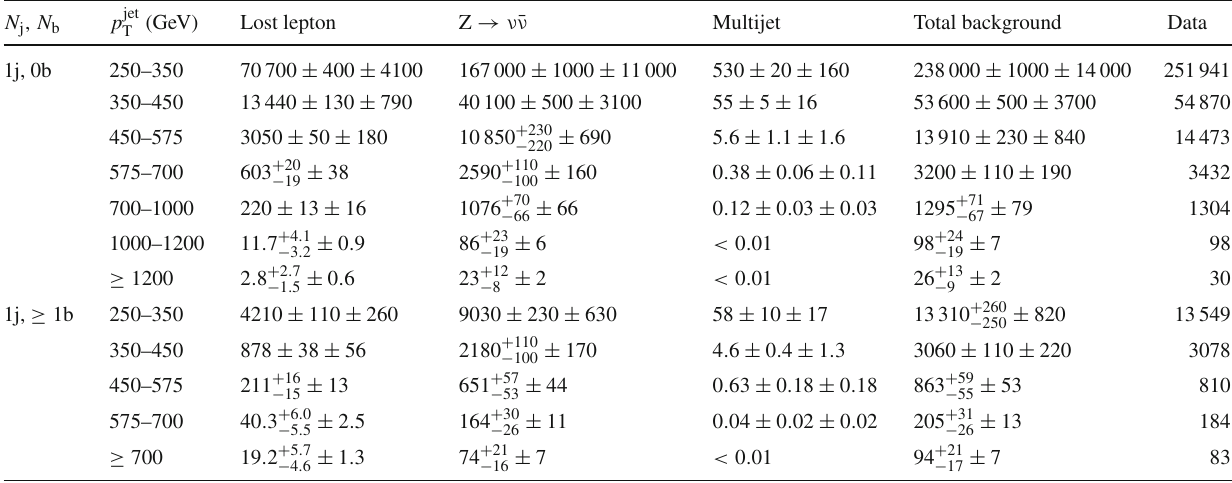
Table 12 Predictions and observations for the 12 search regions with N j = 1. For each of the background predictions, the first uncertainty listed is statistical (from the limited size of data control samples and Monte Carlo samples), and the second is